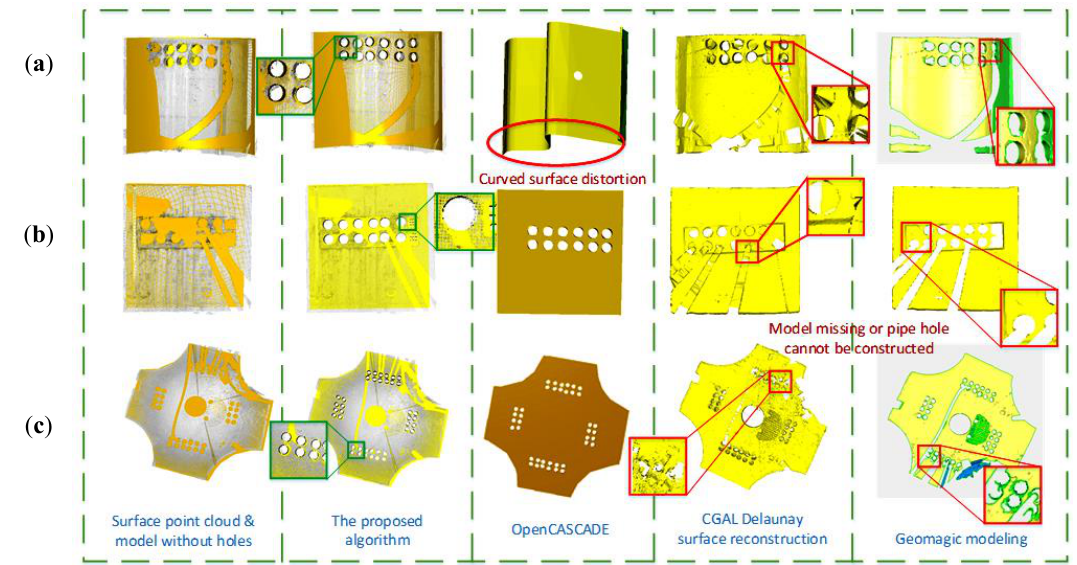
Figure 16. Comparison of various modeling effects of different cable well wall data. ( a ) The curved surface point cloud, ( b ) the rectangular planar point cloud, and ( c ) the irregular planar point cloud.